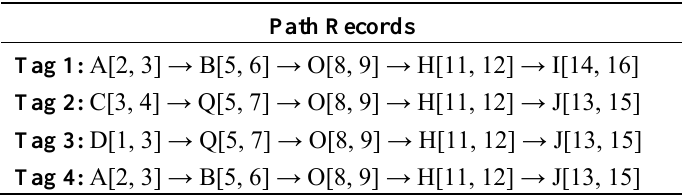
Table 1. The path records of products in supply chain for a